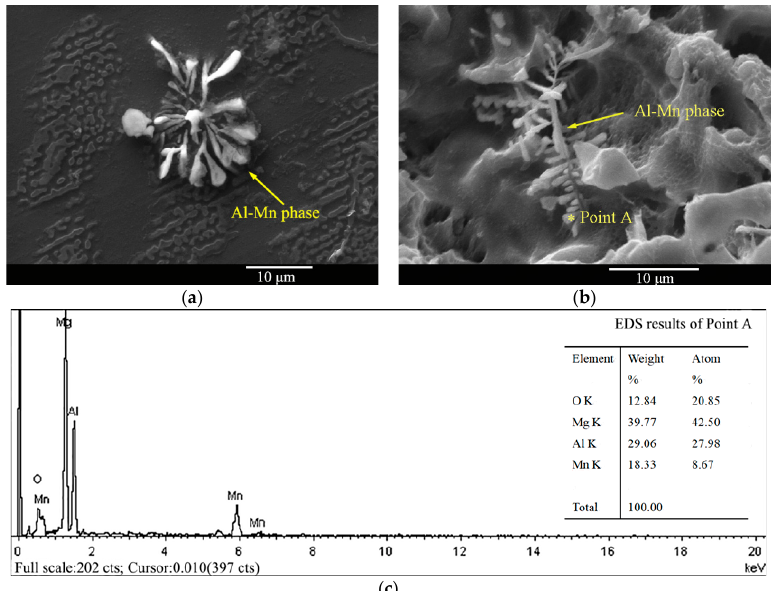
Figure 14. The morphologies of the Al–Mn phase in the as-cast ( a ) and solid-solution-treated ( b ) AM50 Mg alloy samples and the EDS results of point A ( c ).